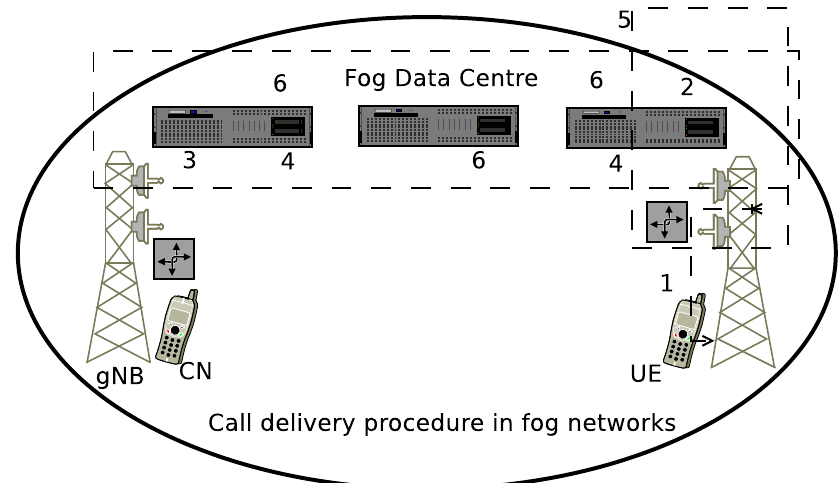
Figure 6. Call delivery procedure in fog computing-based device-driven 5G